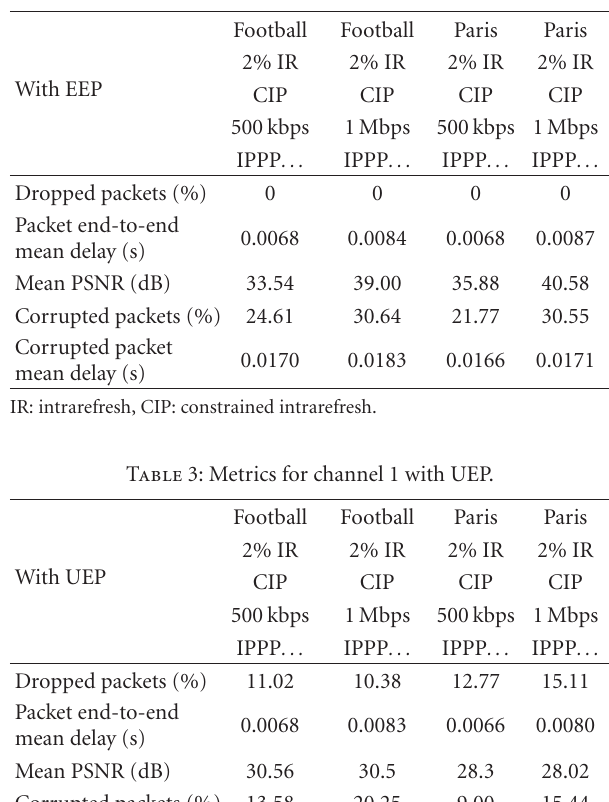
Table 2: Metrics for channel 1 with EEP.